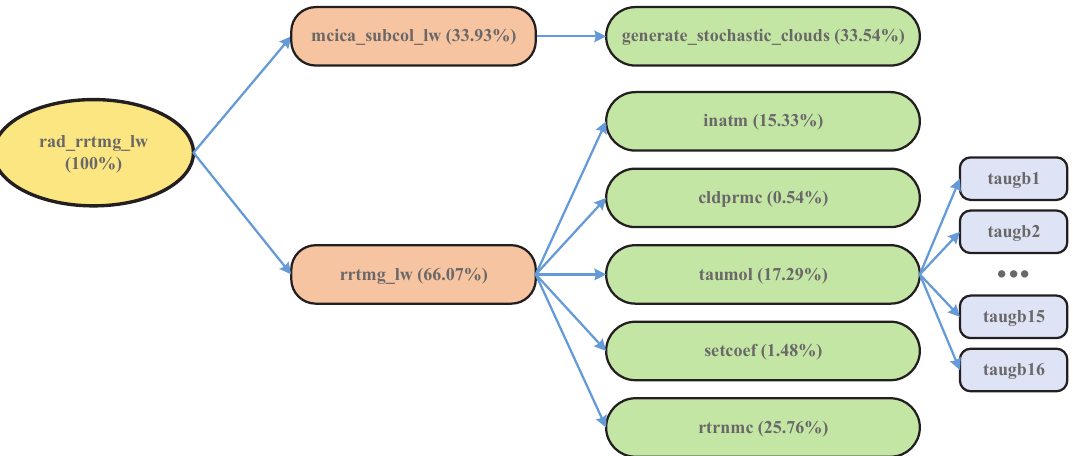
Figure 1. Profiling graph of the original RRTMG_LW code in the CAS-ESM. Algorithm 1: Computing procedure of original rrtmg_lw . subroutine rrtmg_lw (parameters) //ncol is the number of horizontal